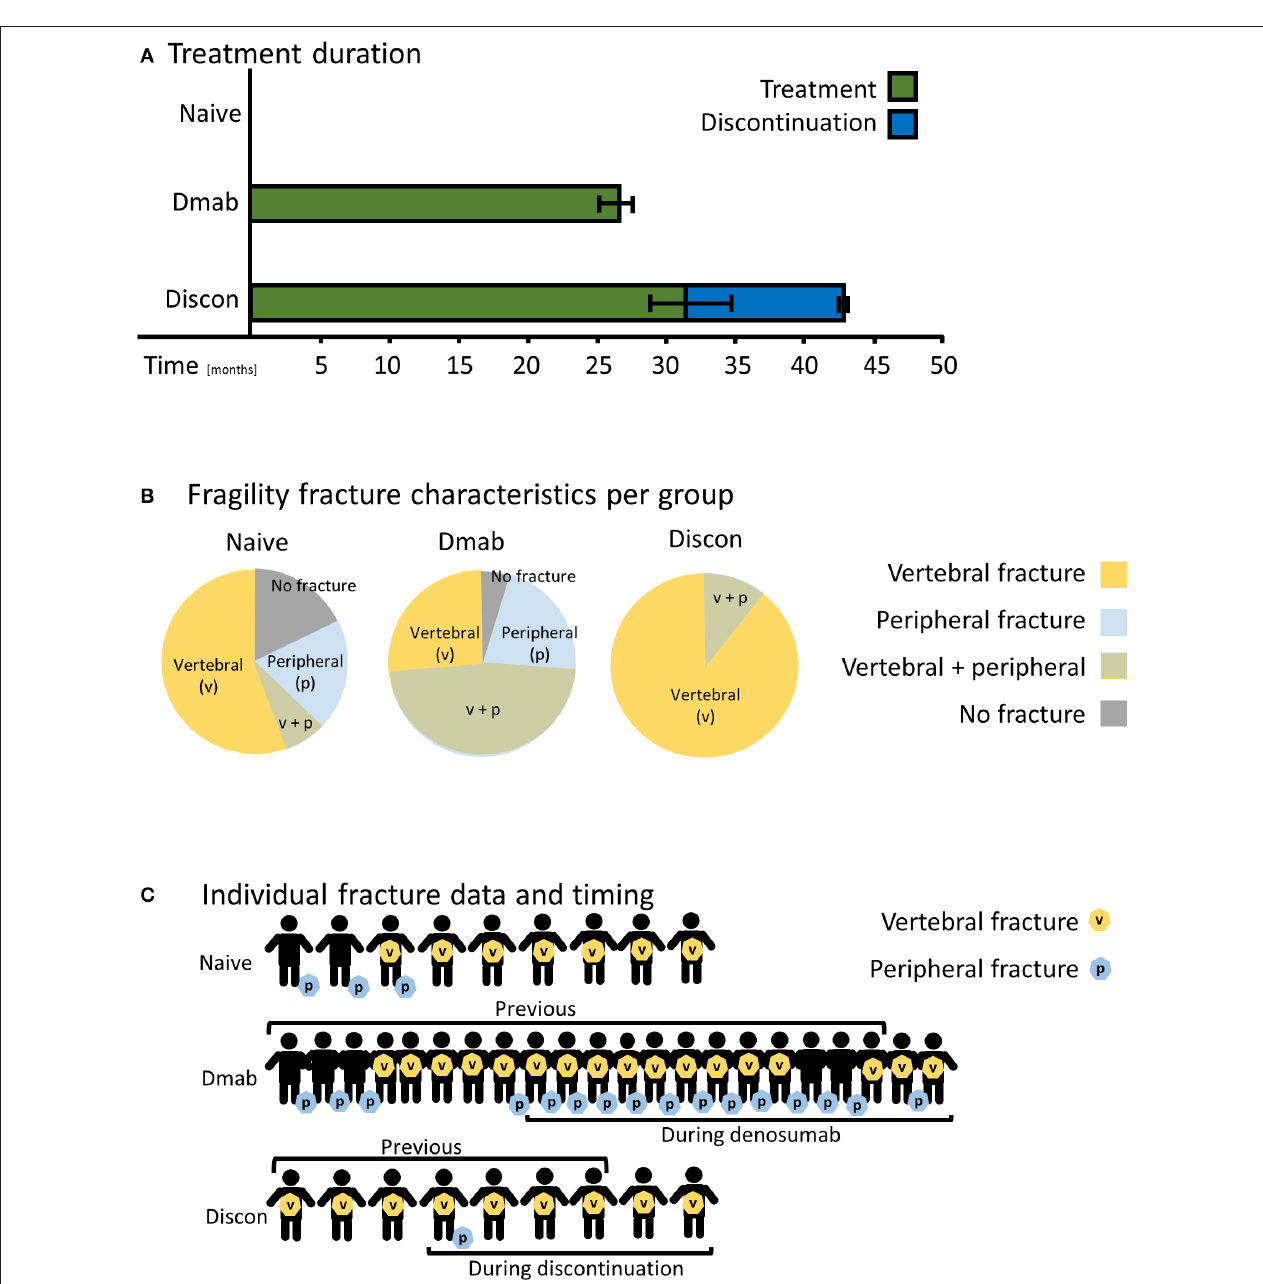
FIGURE 1 | Patient characteristics based on medical records. (A) The average time period in months patients received denosumab (DMab, green) and the time span of discontinued denosumab treatment (Discon, blue). The time period of denosumab treatment did not significantly differ between DMab and Discon. Bar graphs show mean values ± standard error of the mean. (B) Fragility fracture characteristics of the study groups. Circular charts reflect the distribution of fracture types (peripheral or vertebral). (C) Individual fracture data including timing during denosumab treatment or during discontinuation in addition to fracture